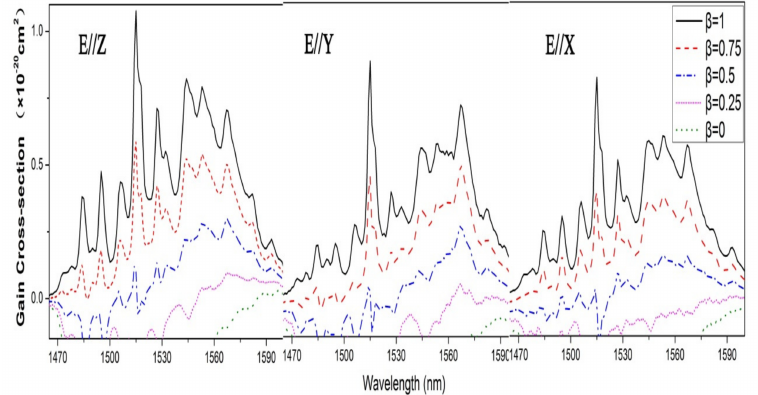
Figure 7. Gain spectra of the 4 I 13/2 → 4 I 15/2 transition of Er 3+ ions in Er:Yb:GMB crystal for E//Z, E//Y and